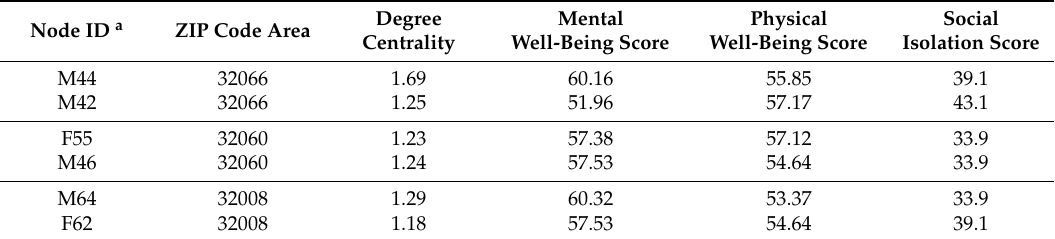
Table 1. Top 2 potential community leaders by ZIP code area and their social-health measures. Node ID a